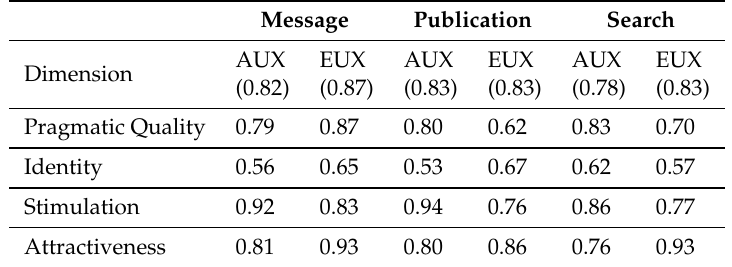
Table 4. AttrakDiff dimensions reliability analysis (Cronbach’s alpha values). Message Publication Search